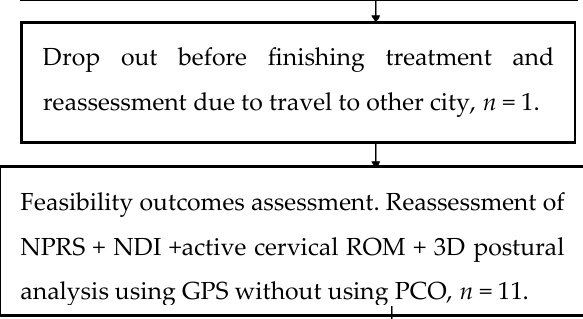
analysis using GPS without using PCO, n = 11.